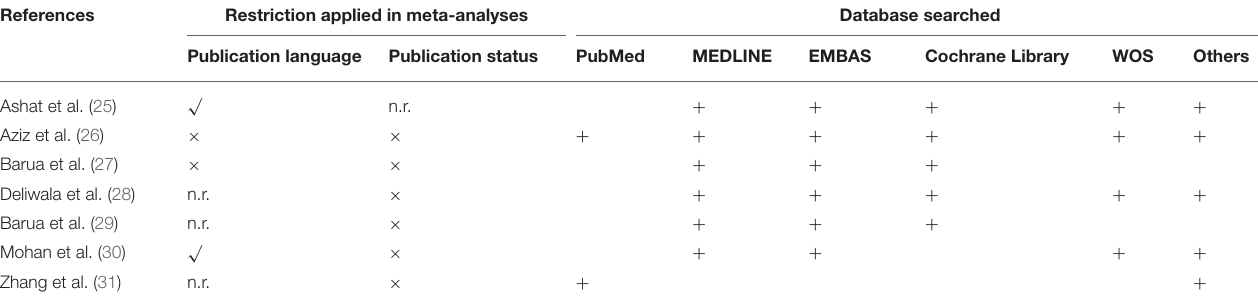
TABLE 3 | Search methodology used by each